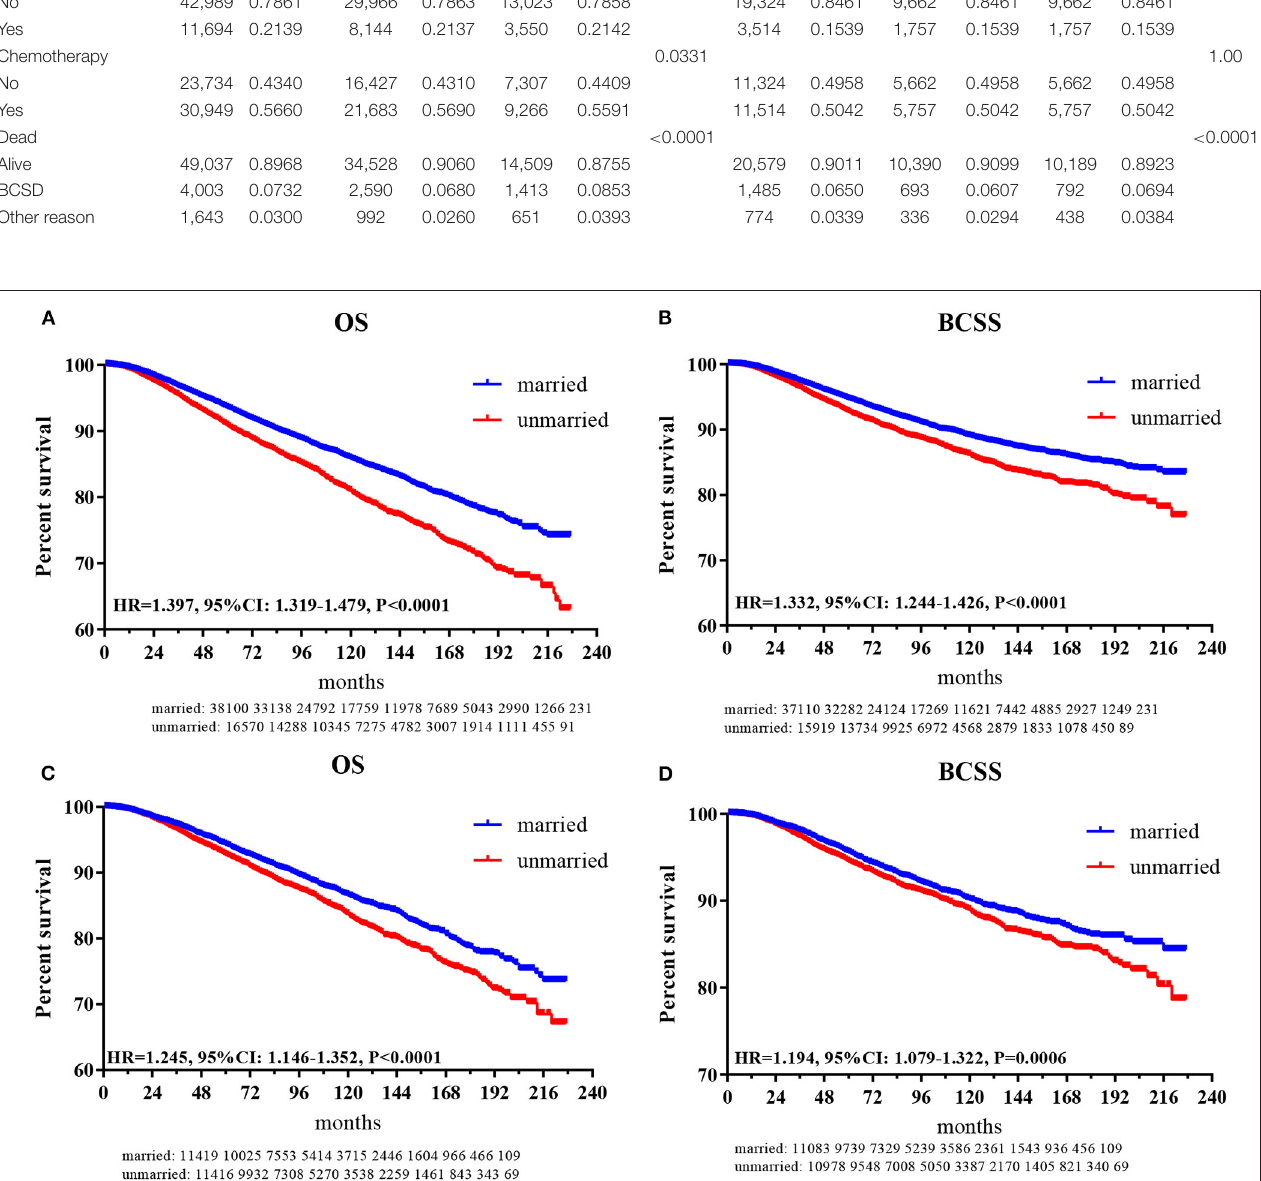
FIGURE 2 | Kaplan-Meier plot to compare married and unmarried patients. (A) Overall survival for patients before PSM; (B) breast cancer-specific survival for patients before PSM; (C) overall survival for patients after PSM; (D) breast cancer-specific survival for patients after PSM.